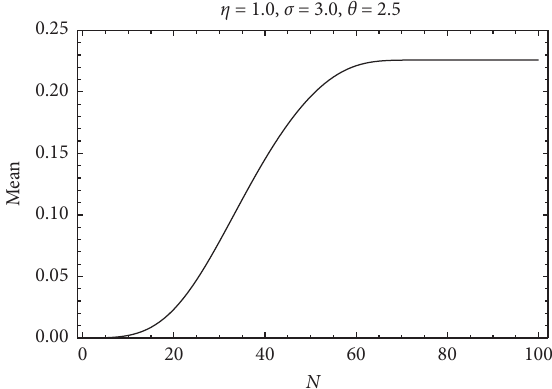
Figure 3: The relationship between the mean and the degree N of Legendre